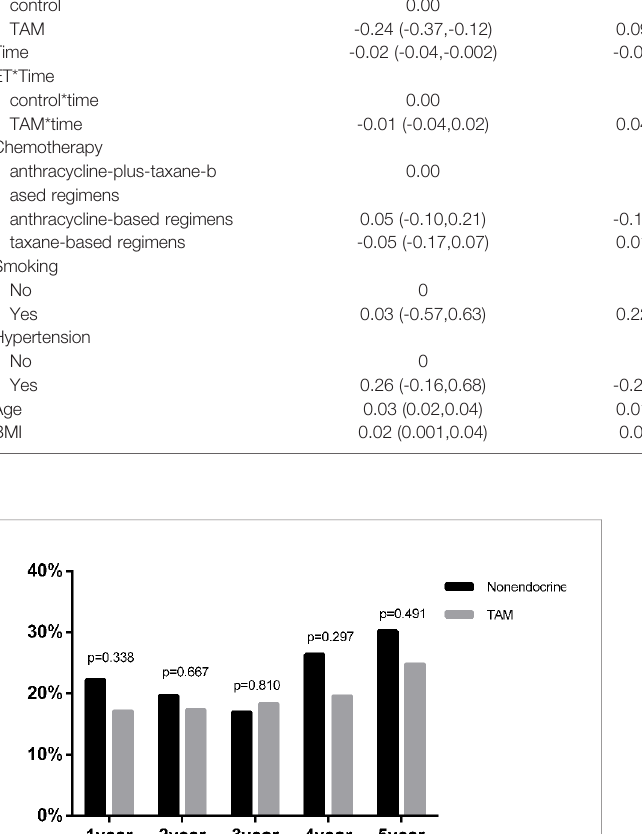
Figure 4 . The means and standard deviations for lipid parameters were still measured at baseline and at 1, 2, 3, 4 and 5 years.